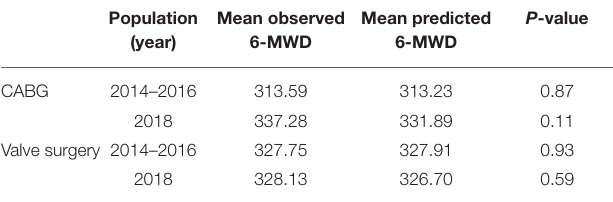
TABLE 3 | Comparison between predicted and observed 6-MWD for internal and external